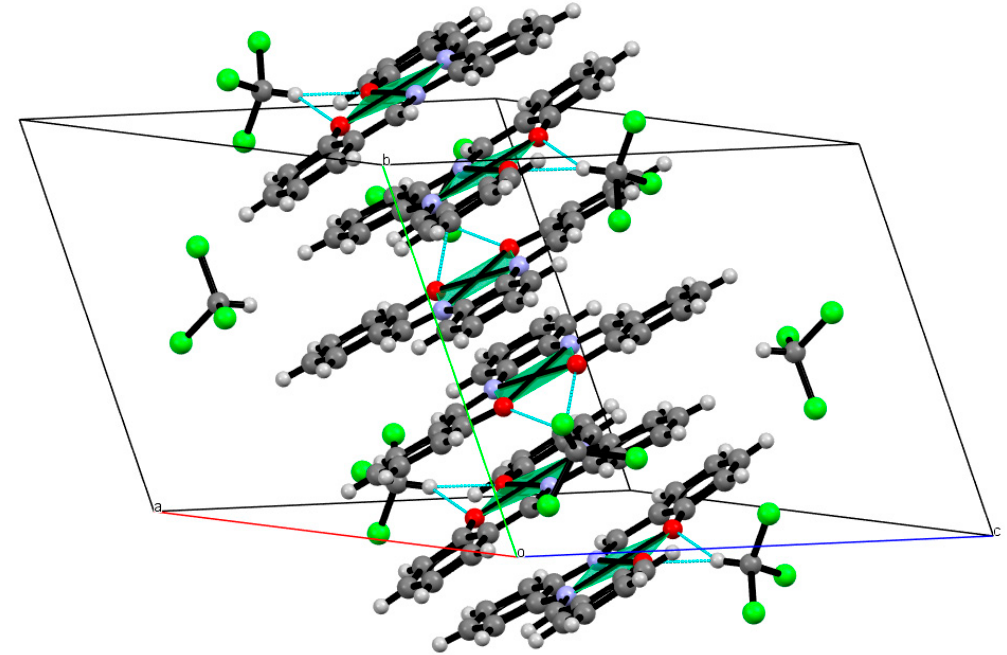
Figure 8. Crystal array of compound Ni salphen , view a tridimensional perspective emphasizing the π -stacking.